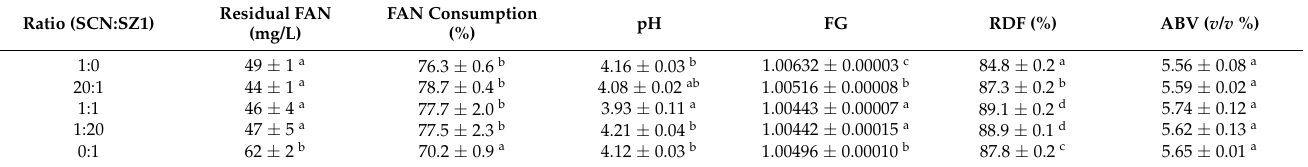
Table 2. Fermented wort characteristics of S. cerevisiae (SCN) and S. pombe (SZ1) monocultures, and three mixed cultures at 20:1, 1:1, and 1:20 initial inoculation ratio in standard-gravity wort (SG 1.049).